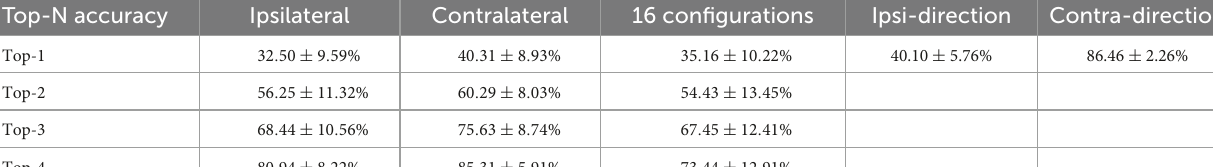
TABLE 1 Offline prediction accuracy ( mean ± SD) using support vector machines (SVMs) for the unimanual and bimanual tasks.